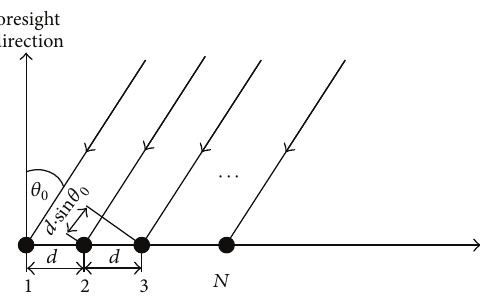
Figure 1: Configuration of the conventional